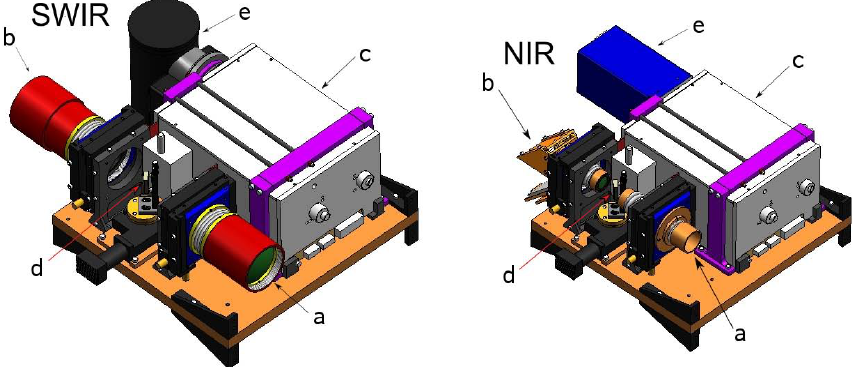
Fig. 2. CAD drawing of the SWIR (left) and NIR (right) spectrometer modules. (a) nadir optics, (b) zenith-sky optics (equipped with telescopes for radiance measurements), (c) spectrometer housing, (d) automated fold mirror, (e) SWIR/NIR detector